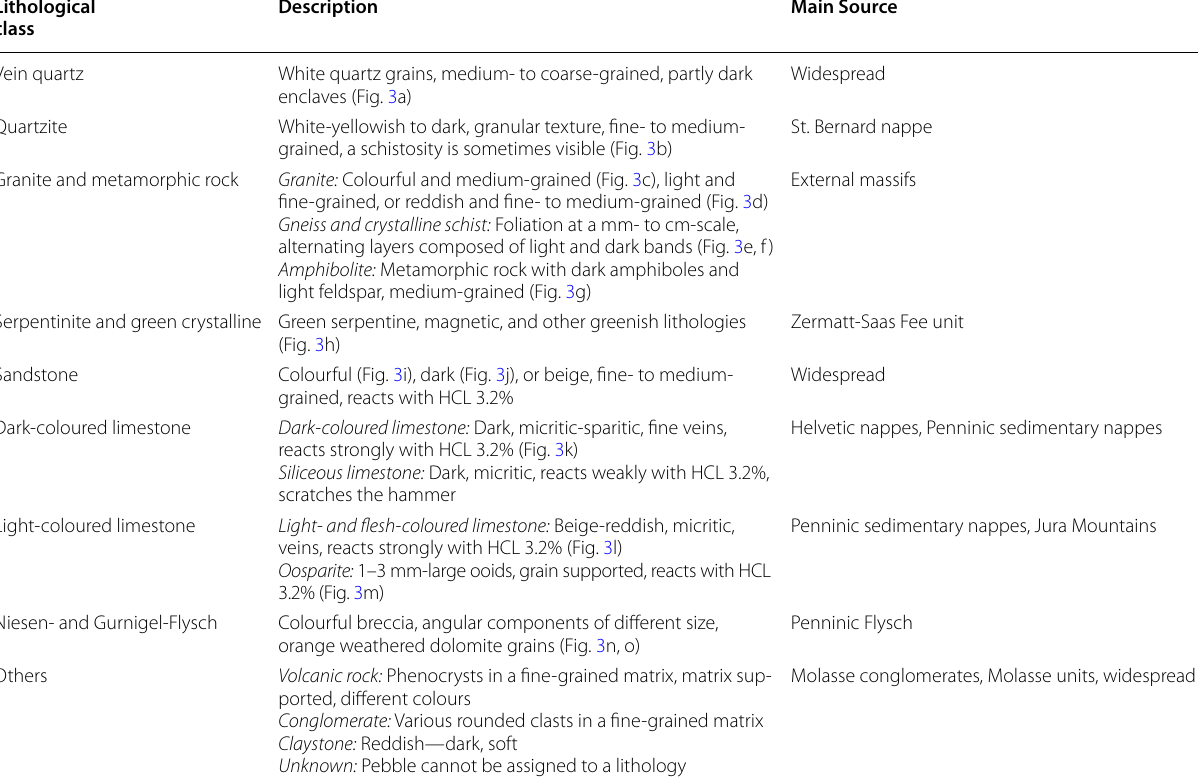
Note that all clast types could also have been derived through reworking of Miocene Molasse conglomerates or older Quaternary gravels. Here, we list the possible original source areas (i.e., prior to reworking)